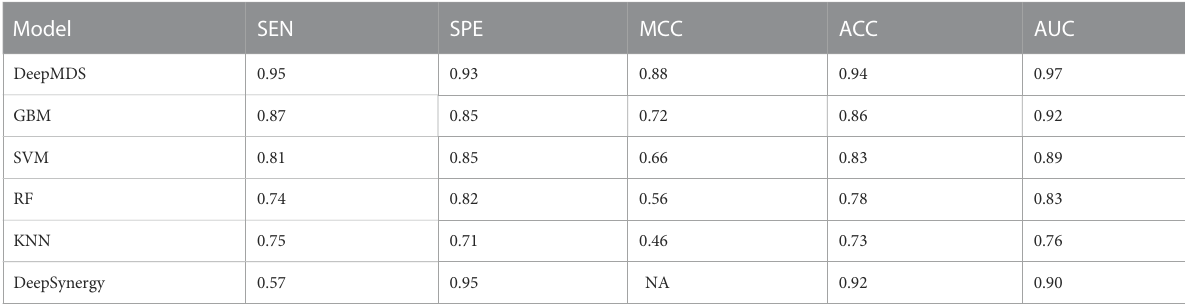
TABLE 3 Model performances of prediction models for classi fi cation